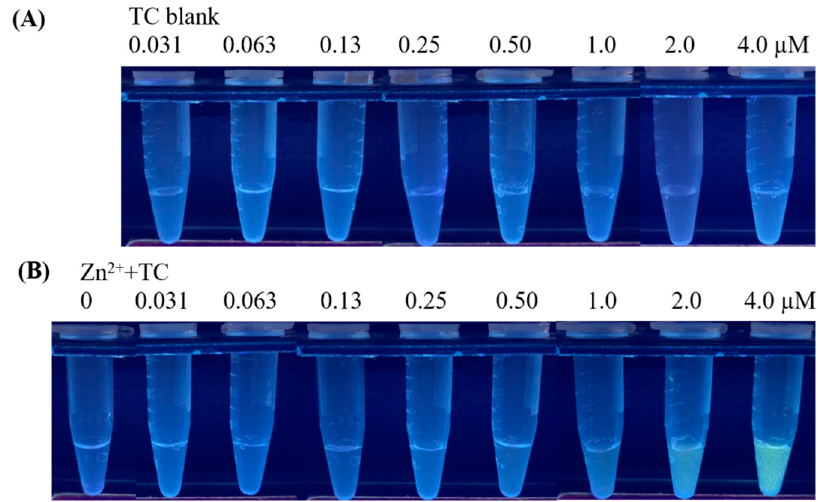
Figure 1. Photographs of the samples containing TC at different concentrations ( A ) without and ( B ) with adding Zn 2+ (1.49 mM) obtained before centrifugation.